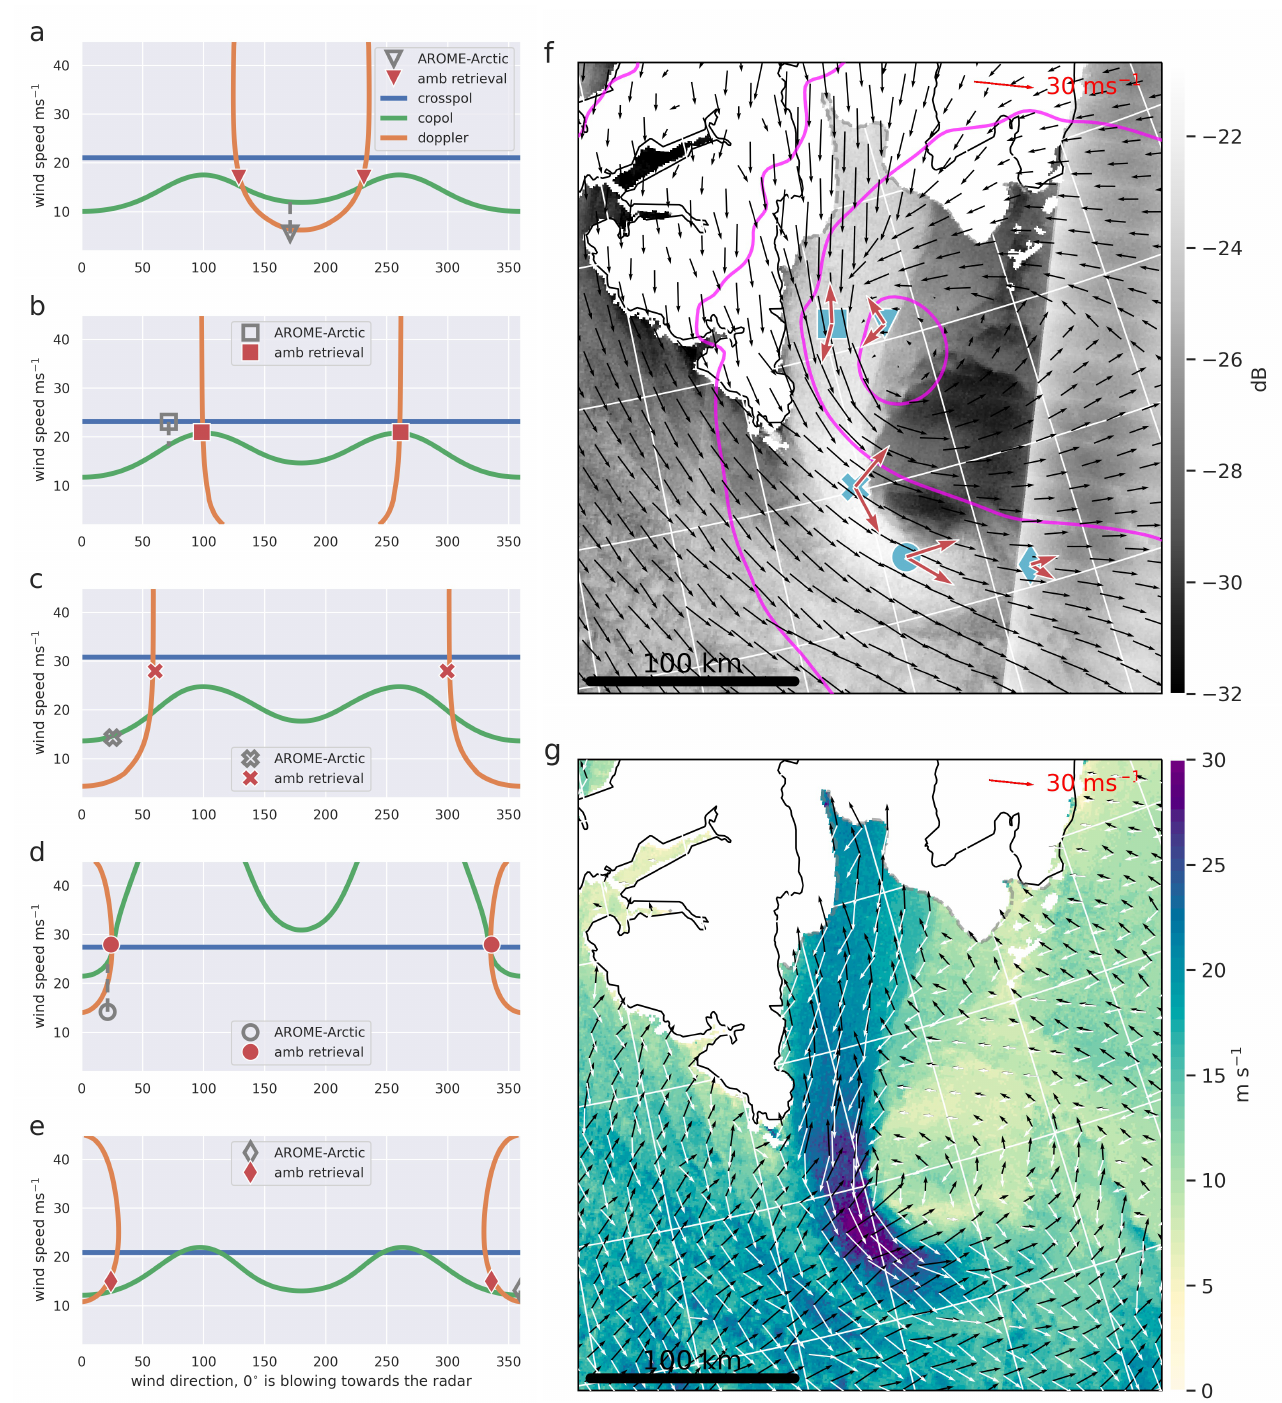
Figure 3. ( a – e ) illustration of the three cost function terms in Equation(2) for five selected locations that are marked in ( f ). The blue, green and orange lines in ( a – e ) represent the crosspol-, copol-, and Doppler terms of Equation(2), respectively. The corresponding AROME-Arctic wind vector for each location is marked with an empty grey symbol and ambiguous wind vectors from the SAR-only retrieval that minimises Equation2 are marked by red symbols in ( a – e ). The direction of 0 ◦ , wind blowing towards the radar, is marked by the red reference arrow in ( f , g ). Angles increase in clockwise direction. ( f ) SAR crosspol backscatter image (grey shading in dB, bright indicates high values) overlaid with sea level pressure (magenta contours) and wind arrows from AROME-Arctic . Blue symbols mark the locations of ( a – e ) and the pairs of red arrows show the ambiguous wind vectors of the SAR-only retrieval. The complete wind field of the SAR-only retrieval is shown in ( g ) with white and black arrows indicating the two wind direction